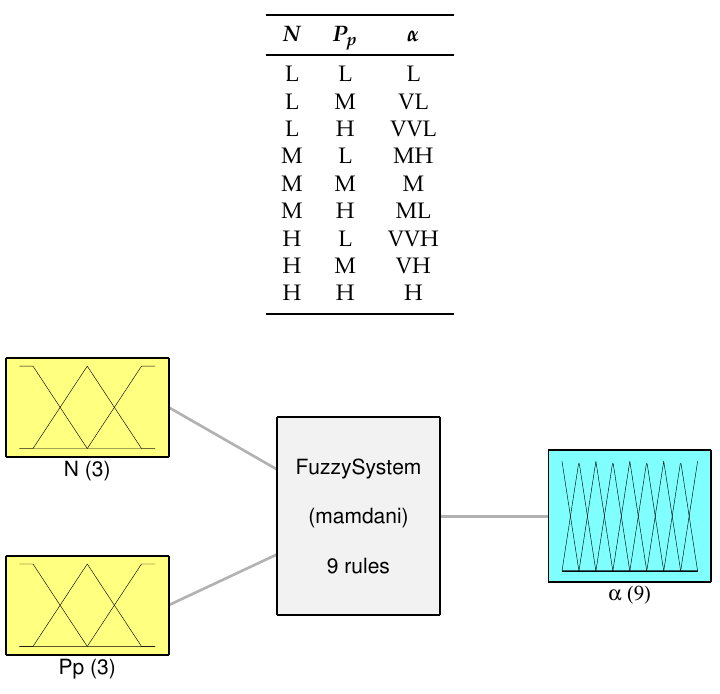
Table 1. Fuzzy rules for FIS(Fuzzy Inference System)- α .